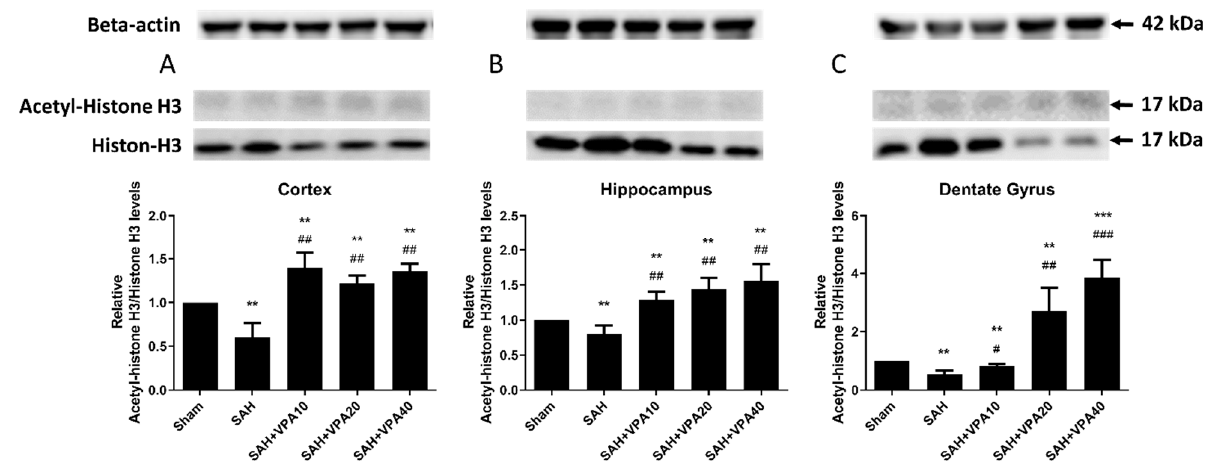
Figure 5. VPA attenuated SAH-induced hypoacetylation of histone H3 in brain tissue. ( A – C ) Top panel: representative expression levels of acetyl-histone H3 and histone H3 protein. Beta-actin was used as control. Lower panel: quantification of relative acetyl-H3 activity. All gels were run in the same experimental conditions ( n = 6). ** p < 0.01,*** p < 0.001, compared with the sham group, ## p < 0.01,### p < 0.001, compared with the SAH group.